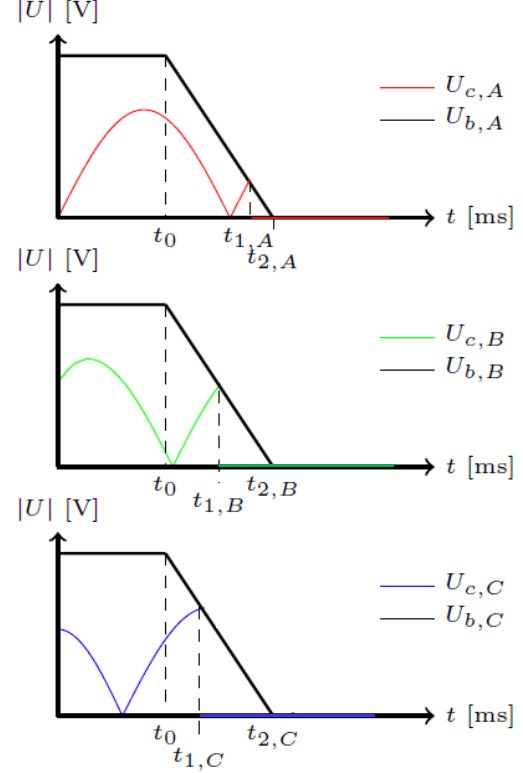
Figure 15. Schematic showing the closing of the VCB in a three phase system, where U the voltage impressed on the vacuum gap. t the first prestrike in the respective phase occurs and the contacts are closed at t